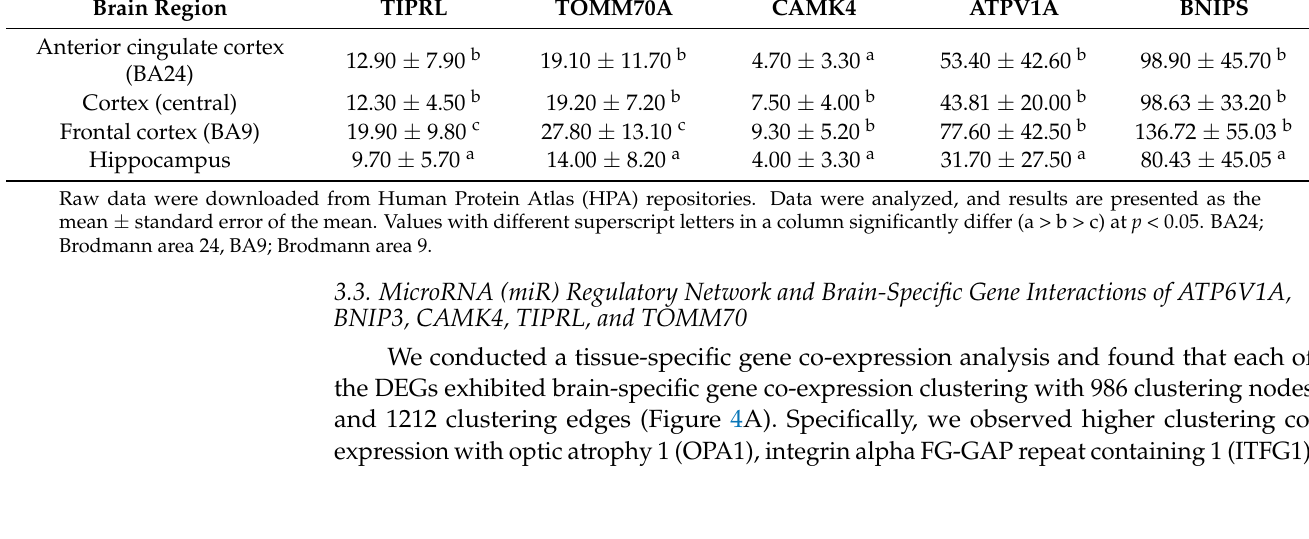
Figure 3. Localization and differential expressions of the ATP6V1A, BNIP3, CAMK4, TIPRL, and TOMM70 ( A ) immunofluorescence staining of the subcellular distribution of the proteins. Protein localization was detected based on the immunohistochemistry from the Human Protein Atlas (HPA) database. Scale bar = 20 μ m ( B ) Bar plots showing differential expression levels of the genes in different brain regions. Table 2. Mean expression data of the ATP6V1A , BNIP3 , CAMK4 , TIPRL , and TOMM70 genes in different brain regions. GTEx RNA-seq (pTPM)